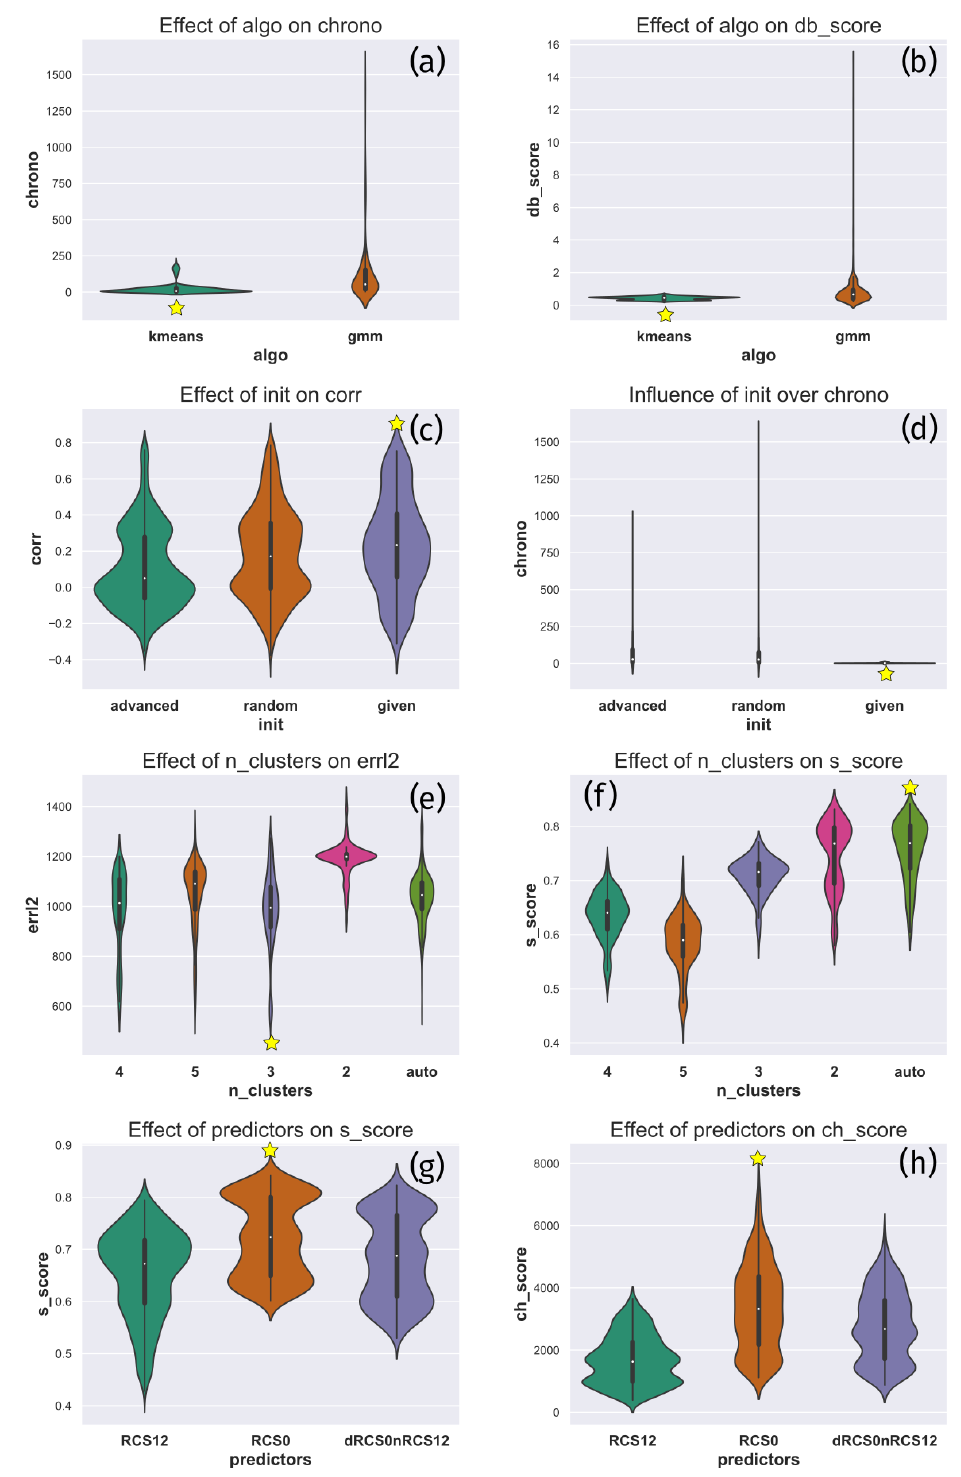
Figure 8. Distribution of the relevant outputs for the critical inputs. The effect of algo on (a) the computing time and (b) the Davies–Bouldin index. The effect of init on (c) the correlation and (d) the computing time. The effect of n_clusters on (e) the root-mean-square error (RMSE) and (f) the silhouette score. The effect of the predictors on (g) the silhouette score and (h) the Calinski–Harabasz index. For each panel, the best parameter value is highlighted by a yellow